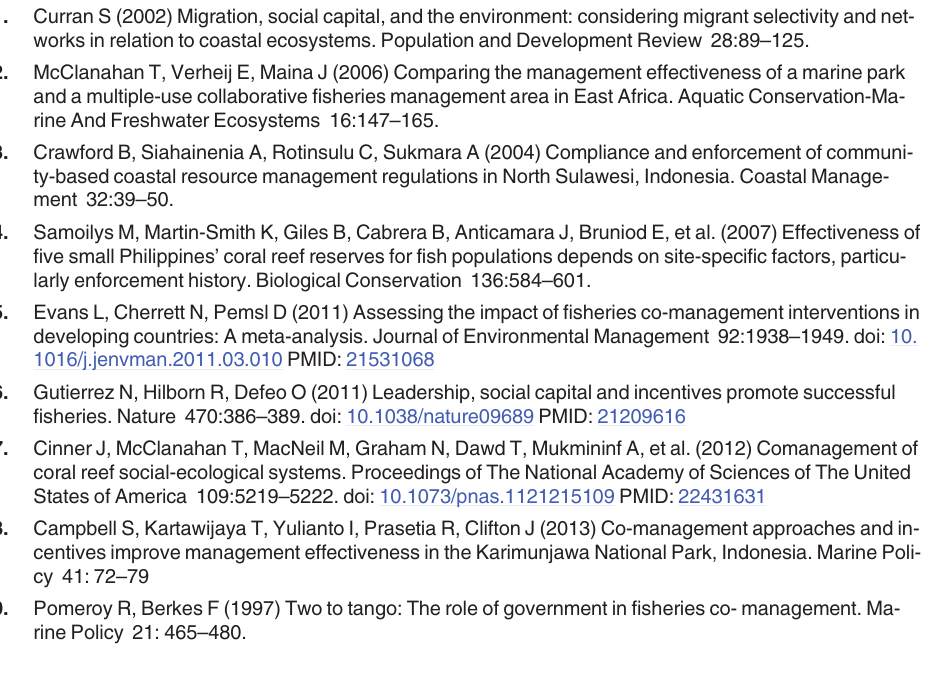
S1 Table. Parameter estimates (standard error) and model fit characteristics for the model of best fit in each community for both the friends and fishing partners ’ social networks. S2 Table. Survey questions used to assess food security for fishermen adapted from USDA ’ s Six Item Short Form of the Food Security Survey (Interviewees responded with agree/disagree/neither agree nor disagree). S3 Table. Survey question used to assess gear ownership amongst fishermen in four com- munities around Pearl Lagoon, Nicaragua. S4 Table. Survey questions used to assess enforcement behavior amongst fishermen in four communities around Pearl Lagoon,